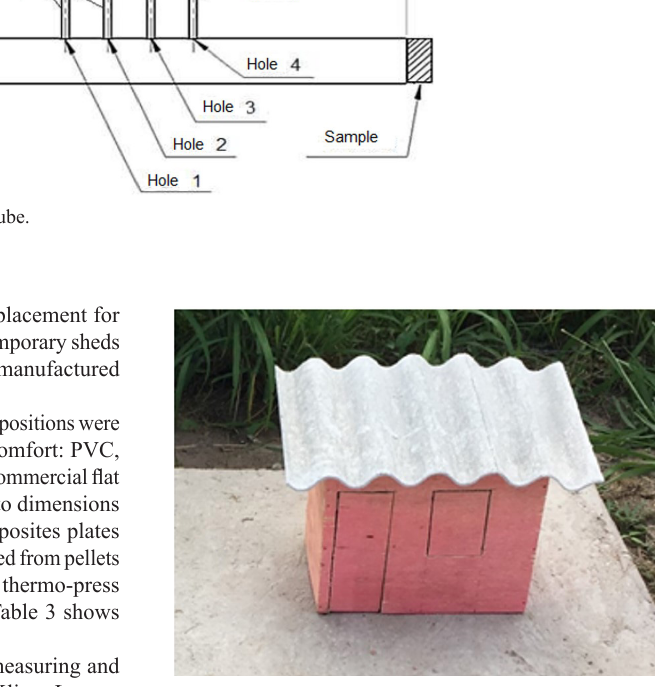
Figure 2. Shed prototype for thermal comfort